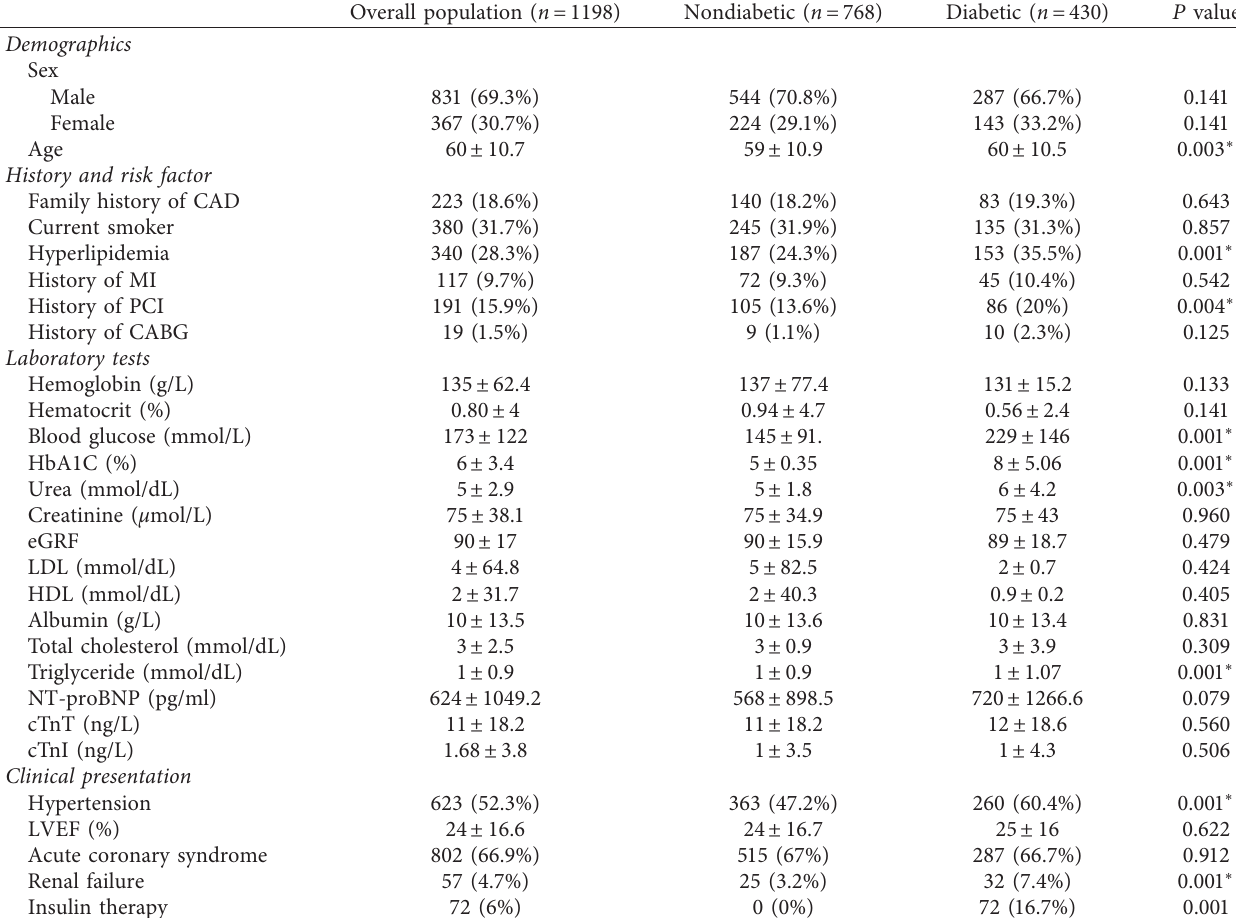
Figure 1: Study diagram. DCB: drug-coated balloon; FU: follow-up; MACEs: major adverse cardiac events; PCI: percutaneous coronary intervention; TLF: target lesion failure. Table 1: Patients’ baseline